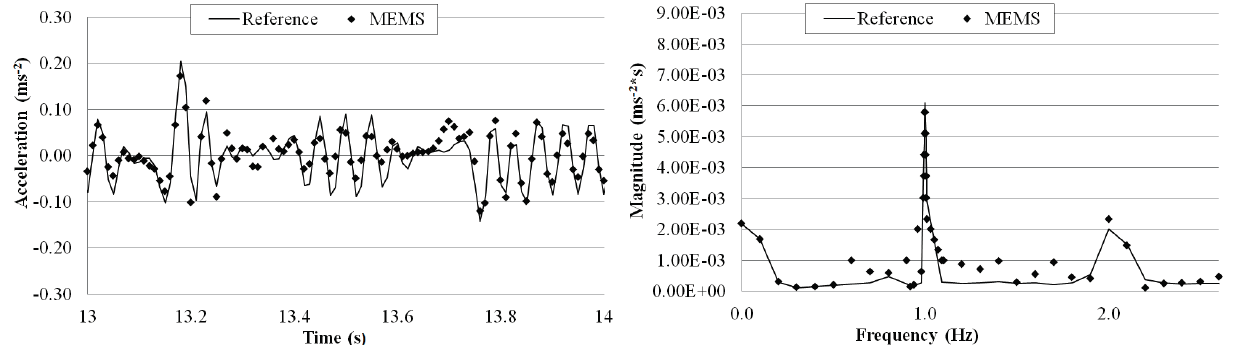
Figure 23. Comparison of measurements by the two sensors in time and frequency domains (1 Hz Periodic Wave